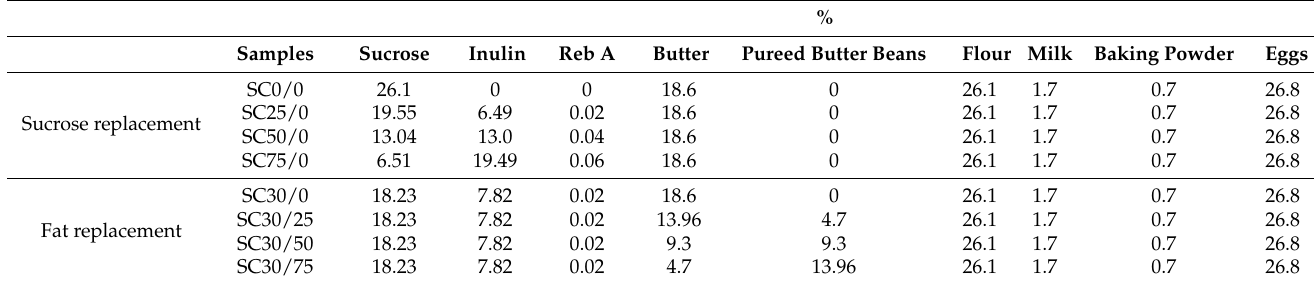
Table 1. Formulation of different sponge cake